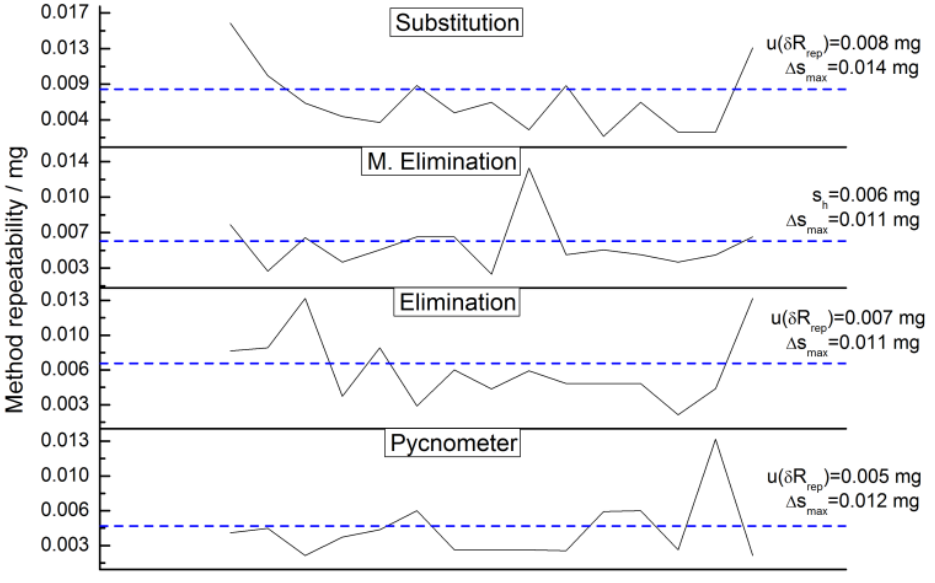
Figure 15. Repeatability for each weighing method blue line is the typical one .